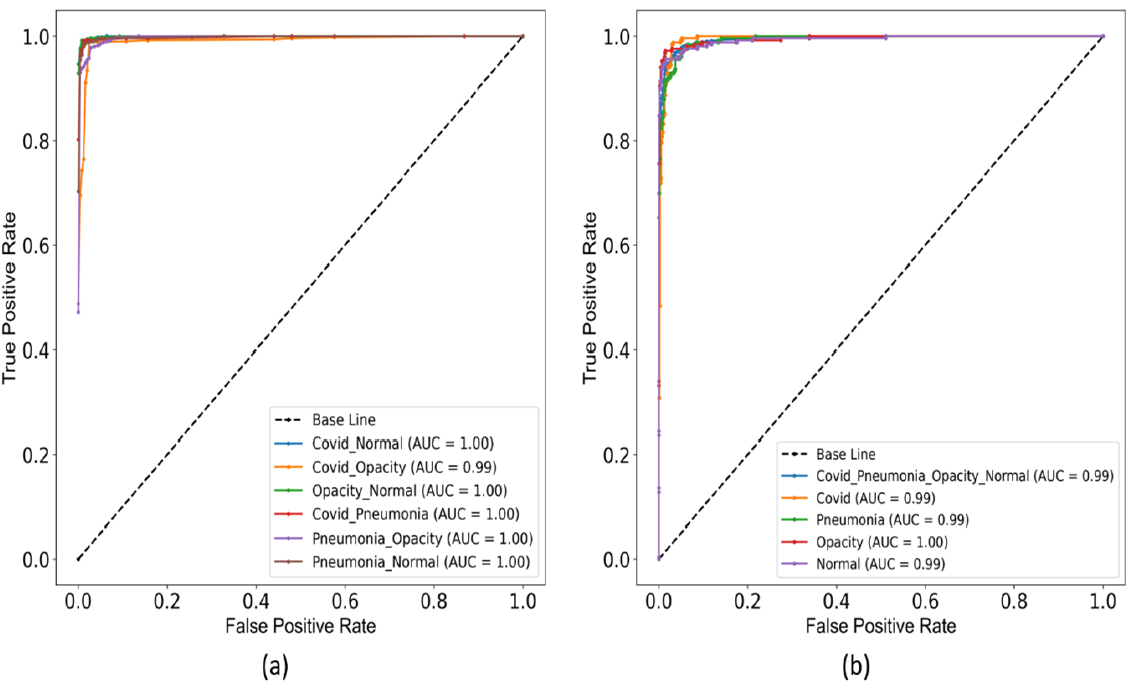
Figure 5. Receiver operating characteristic (ROC) curves on the test dataset. ( a ) Binary classification. ( b ) Multiclass classification.